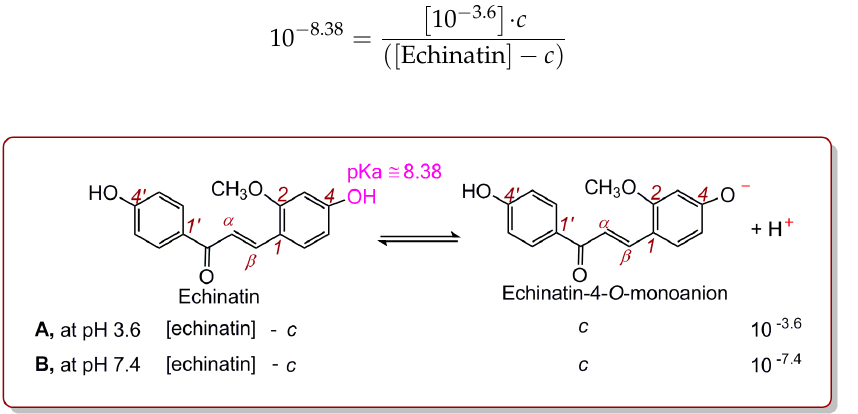
Figure 4. Ionization equilibrium of the 4-OH group in echinatin at pH 3.6 (A) and 7.4